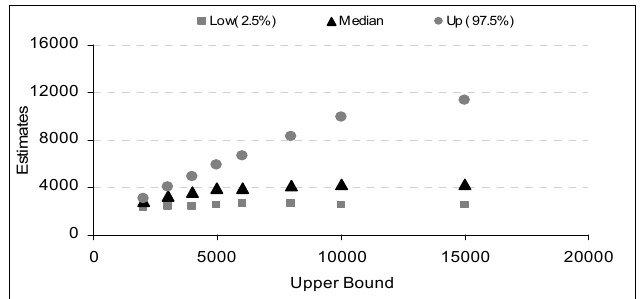
Figure 3 – Dataset C) Independence among sources and a significant effect of continuous covariate: non parametric point estimates of the population size and 95% C.I. according to the upper bound (Bayesian Capture-Recapture